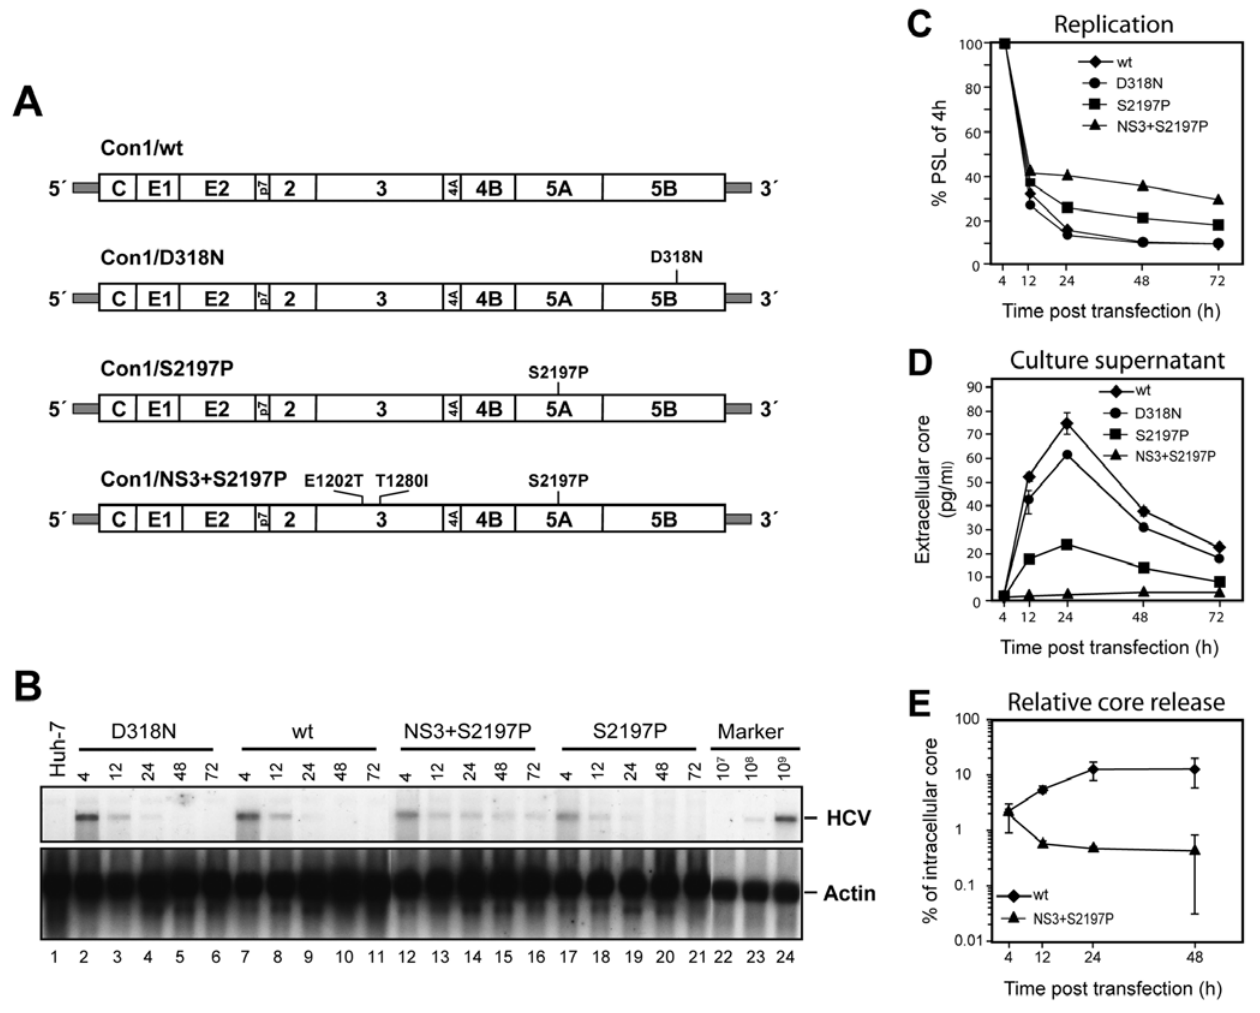
Figure 1. Transient replication of HCV Con1-derived constructs in Huh-7 cells and release of core protein from transfected cells. (A) Schematic representation of transfected RNA genomes. The polyprotein is indicated by an open box, the individual functional proteins are separated by vertical lines. Non-translated regions are depicted as shaded bars, REMs and the position of the mutation destroying the active site of the NS5B RdRp (D318N) are specified above the respective positions in the coding region. (B) Transient RNA replication of full length Con1-derived genomes. Ten m g of in vitro transcribed RNA of the constructs specified in the top were transfected into Huh-7 cells that were harvested at given time points. Total cellular RNA was prepared and HCV RNA and beta-actin RNA were detected by Northern hybridization. (C) The amount of HCV RNA was determined by phospho imaging and is expressed relative to the input determined 4 h post transfection. Values were normalized for equal RNA loading as determined with the beta-actin specific signal. (D) Time course of accumulation of HCV core in cell culture supernatant of transfected Huh7 cells. Cells were transfected and seeded as described in (A). At given time points, culture medium was harvested, filtered through 0.45 m m pore-size filters, and analysed for core protein by ELISA. Duplicate measurements, mean value of duplicates and standard errors of the means are given. (E) Efficiency of core release from cells transfected with Con1/wt or the adapted genome Con1/NS3 + S2197P [27]. Amounts of core protein accumulated intracellularly or in cell culture medium were determined by ELISA and used to calculate the percentage of intracellular core protein released into the supernatant of transfected cells for each given time point. Mean values of two independent electroporations including standard errors of the means are